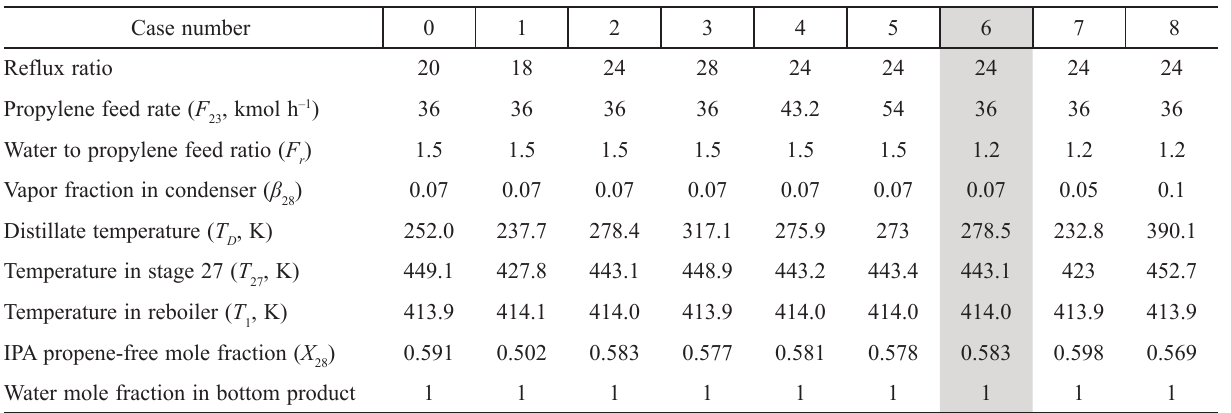
Table 3 – Optimization results of four operating variables. Case 0 is the base case and optimum values are highlighted.